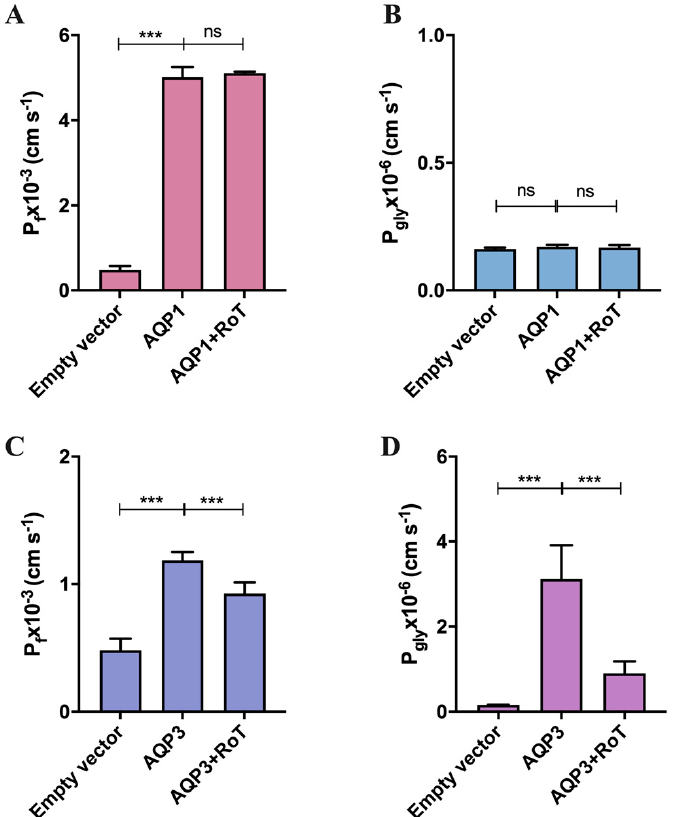
Figure 3. ( A ) Water permeability (P f ) and ( B ) glycerol permeability (P gly ) of yeast cells transformed with the empty vector, and cells expressing hAQP1 before and after treatment with RoT (100 µM); ( C ) Water permeability (P f ) and ( D ) glycerol permeability (P gly ) of yeast cells transformed with the empty vector, and cells expressing hAQP3 before and after treatment with RoT (100) µM. Data are shown as mean ± SD of three independent experiments. *** p < 0.001, ns, non-significant; empty vector vs. non-treated vs. treated cells.